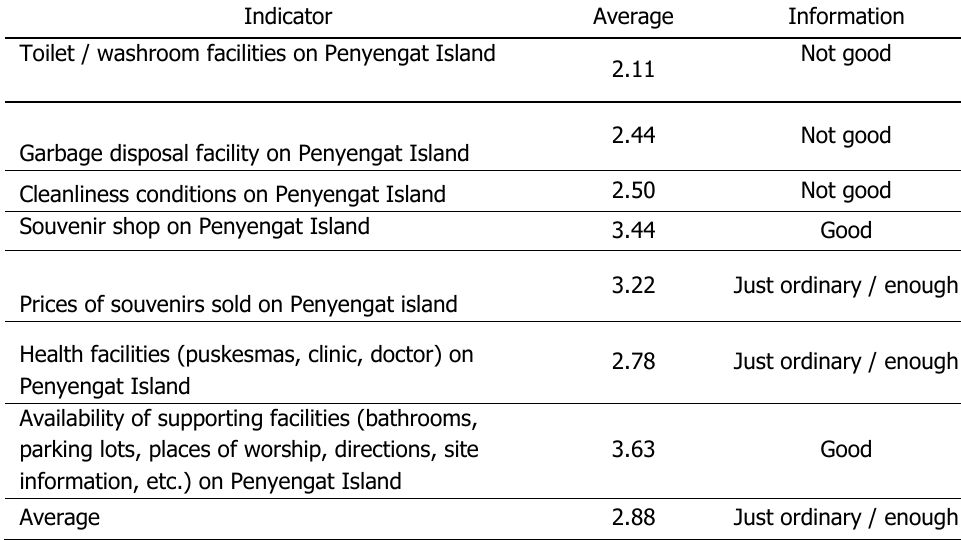
Table 7. The amenity attribute assessment indicators Indicator Average Information